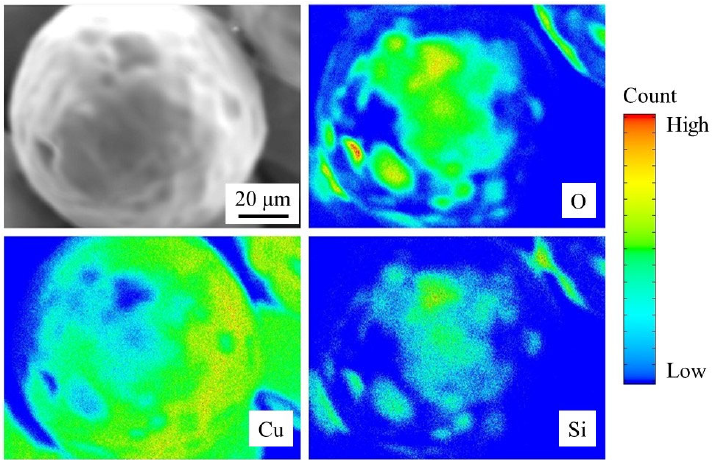
Figure 7. Electron probe microanalysis results of coated Cu particles.